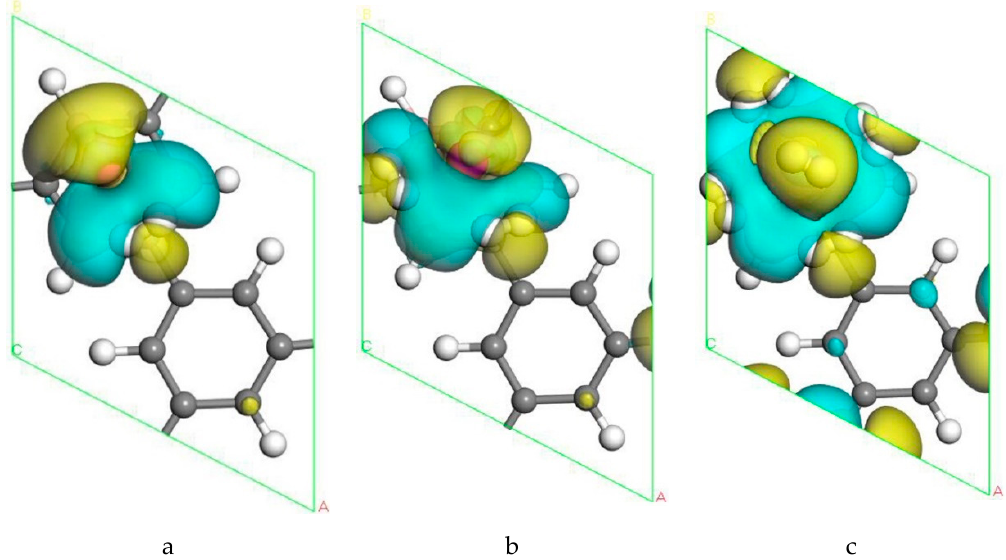
Figure 7. Electronic charge density di ff erence for the Sc-B / PG system in the presence of ( a ) one H 2 molecule; ( b ) two H 2 molecules; ( c ) five H 2